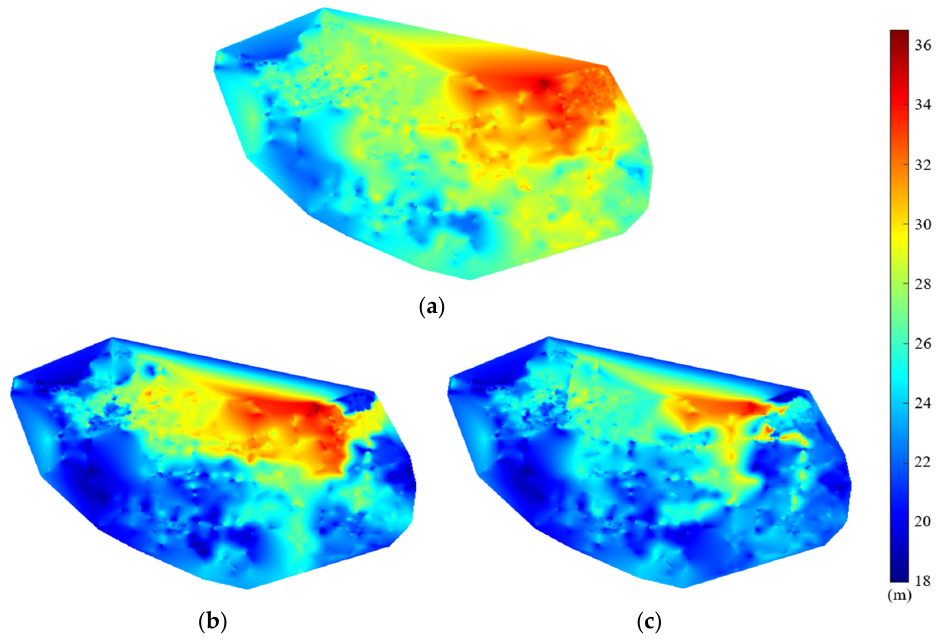
Figure 8. Pressure distribution in peak demand period: ( a ) Original; ( b ) Scheme A; ( c ) Scheme B.